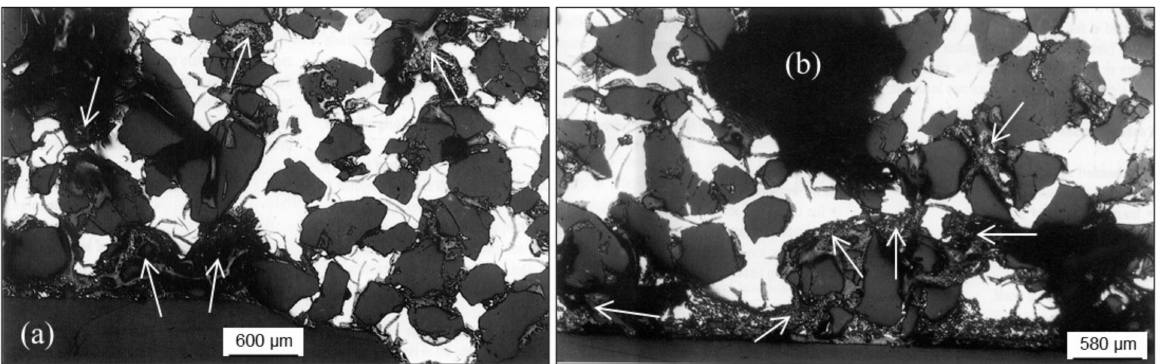
Figure 18. Microscopic views of the layer obtained in a metal penetration with chemical reaction: ( a ) external area and ( b ) internal area. Compounds formed due to chemical reactions are pointed with